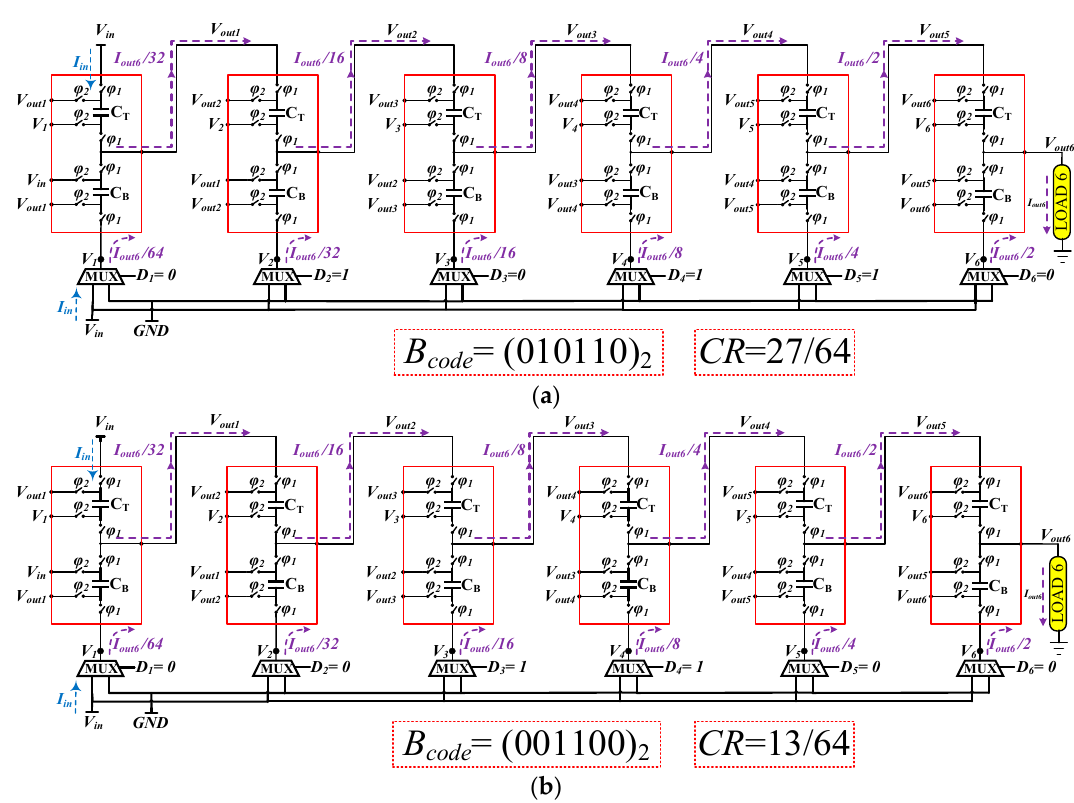
Figure 9. A 6-bit SSC-DVS with single-output based on: ( a ) B code = (010110) 2 ; and ( b ) B code = (001100) 2.